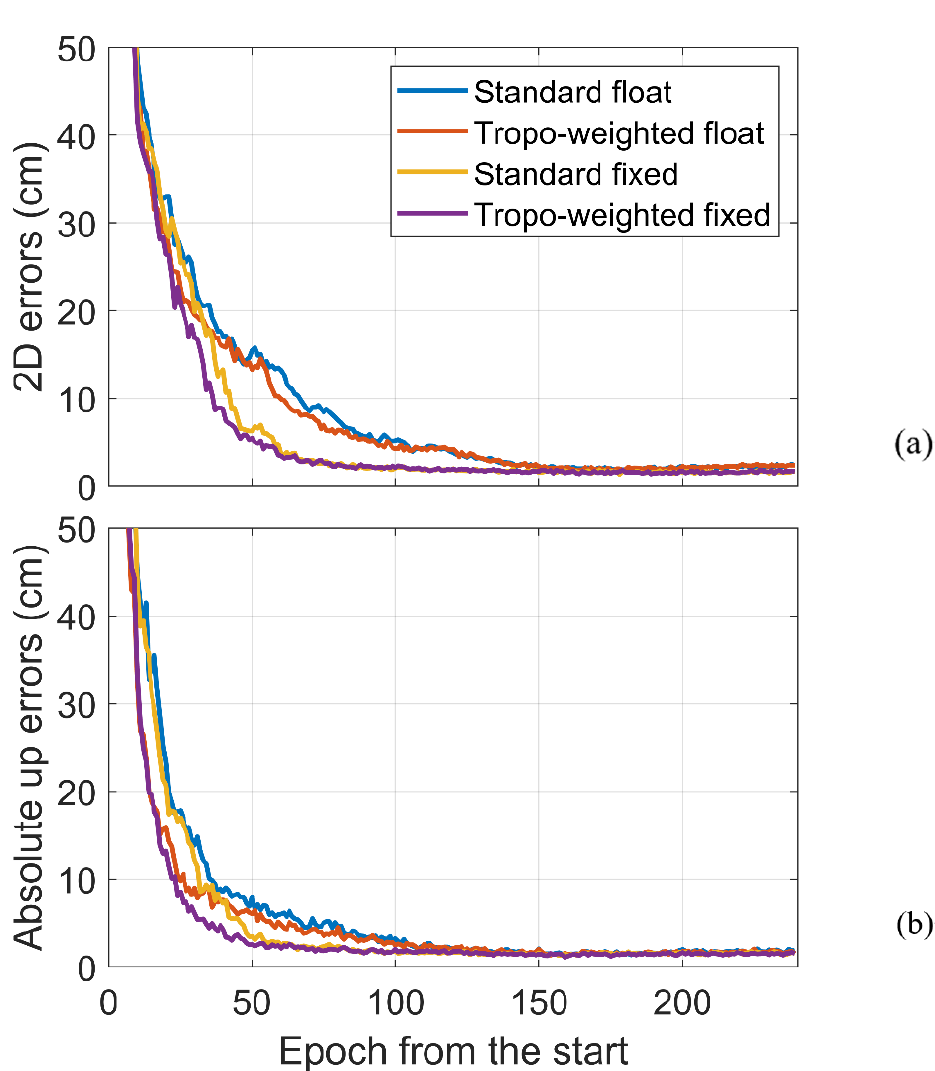
Figure 7. ( a ) Horizontal and ( b ) absolute up positioning errors in kinematic positioning mode at each epoch from the start with 90% probability .